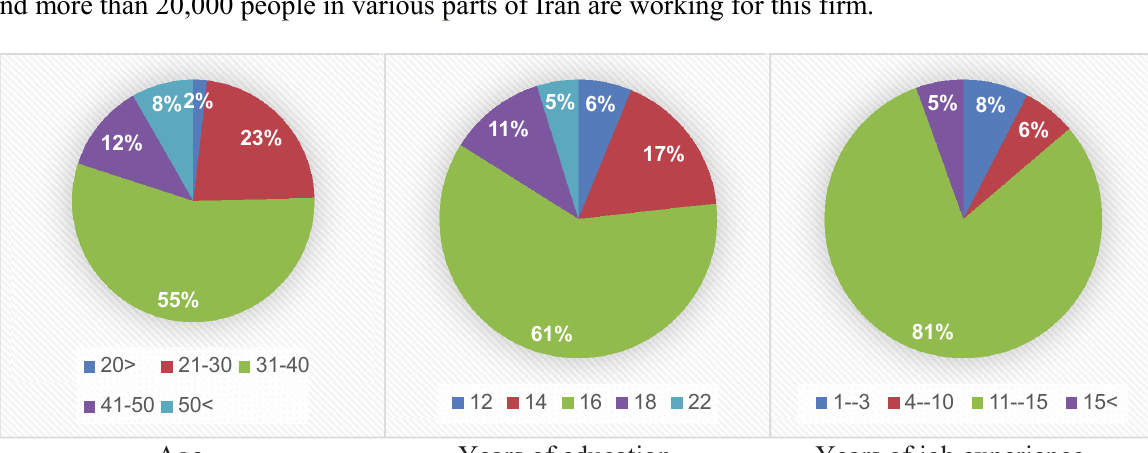
Fig. 1. Personal characteristics of the